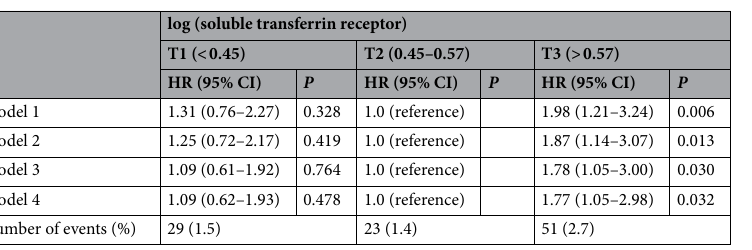
Table 2. Risk of all-cause mortality according to tertile of log(soluble transferrin receptor). HR hazard ratio, CI confidence interval. Model 1: unadjusted. Model 2: Adjusted for age, race, and education. Model 3: Model 2 + body mass index, serum hemoglobin, ferritin, C-reactive protein, baseline estimated glomerular filtration rate, and random urine albumin-to-creatinine ratio. Model 4: Model 3 + diabetes mellitus, hypertension, cardiovascular disease, and